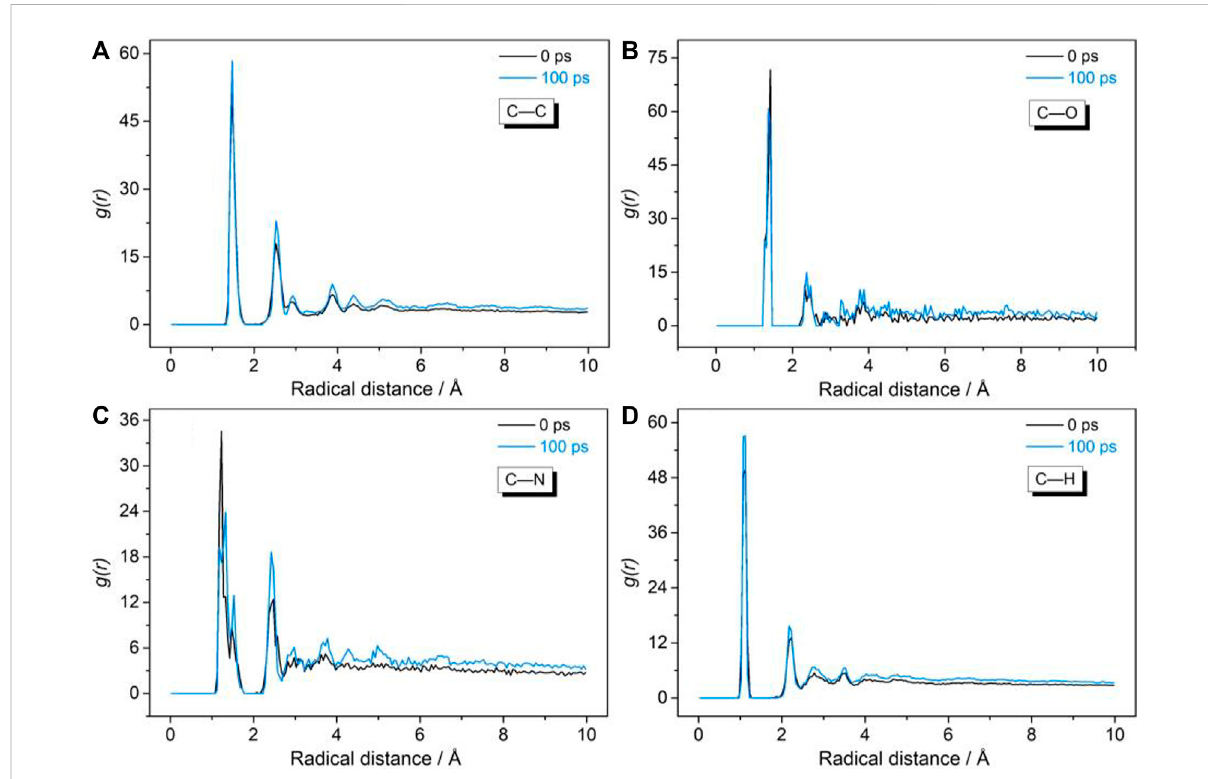
The (A) C-C, (B) C-O, (C) C-N, and (D) C-H radical distribution functions of the friction system before and after shear